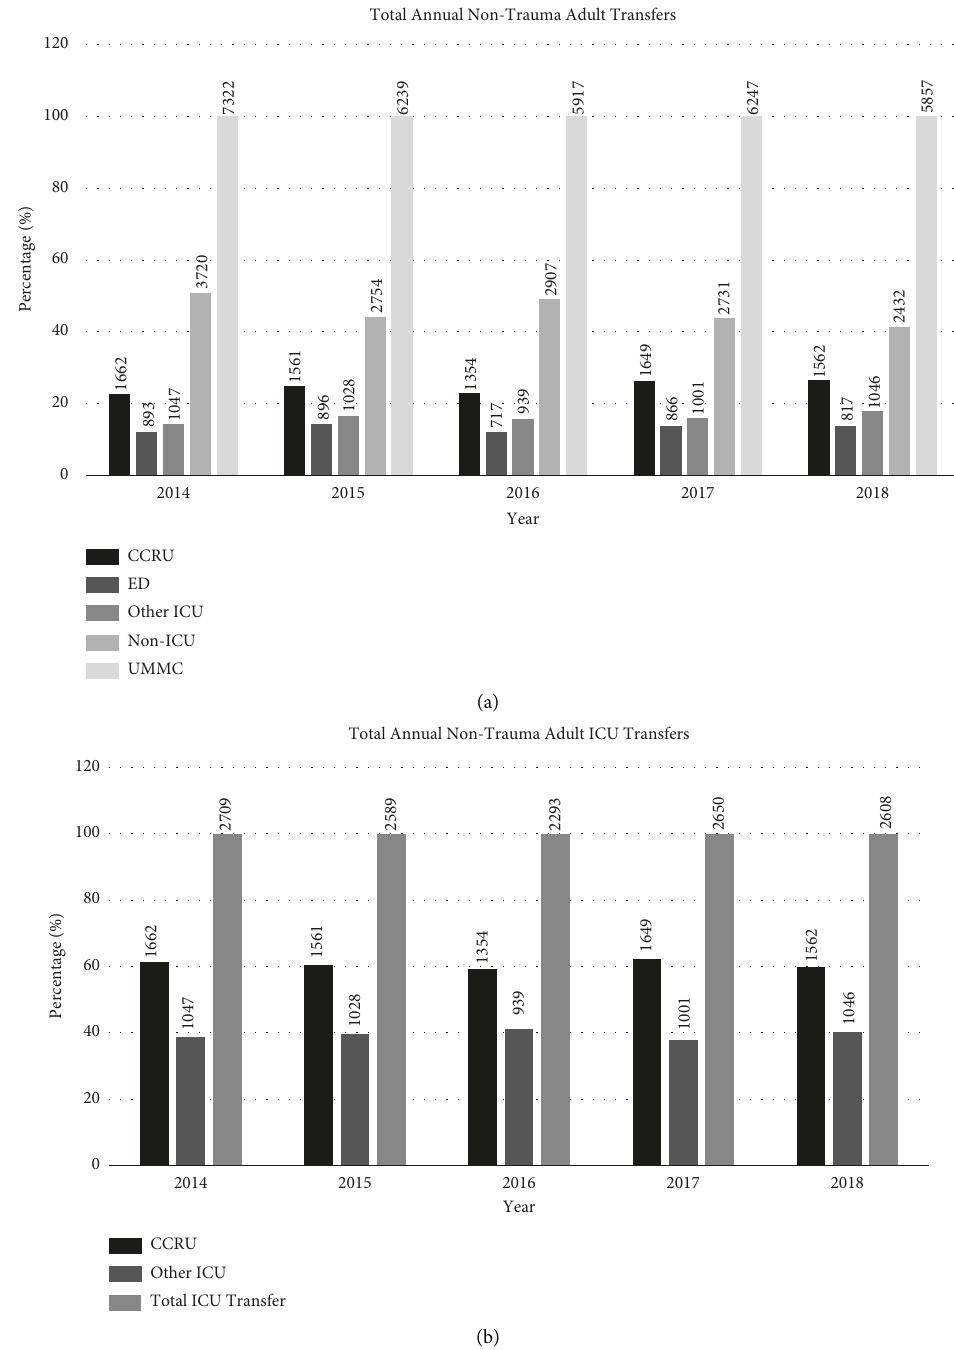
Figure 2: (a) Total annual non-trauma adult transfers from other hospitals to our academic medical center. The y -axis represents the number of patients as a percentage of the total adult transfers to our medical center, which is set as 100%. The x -axis shows the name of each unit per year. The number on each bar represents the number of transfers. Abbreviations: CCRU, critical care resuscitation unit; ED, emergency department; ICU, intensive care unit; UMMC, University of Maryland Medical Center. (b). Total annual non-trauma adult transfers from other hospitals to any one of our academic medical center’s adult ICUs. The y -axis represents the number of patients as a percentage of the total adult transfers to any ICU at our medical center, which is set as 100%. The x -axis shows the name of each unit per year. The number on each bar represents the number of transfers. Abbreviations: CCRU, critical care resuscitation unit; ED, emergency de- partment; ICU, intensive care unit; UMMC, University of Maryland Medical